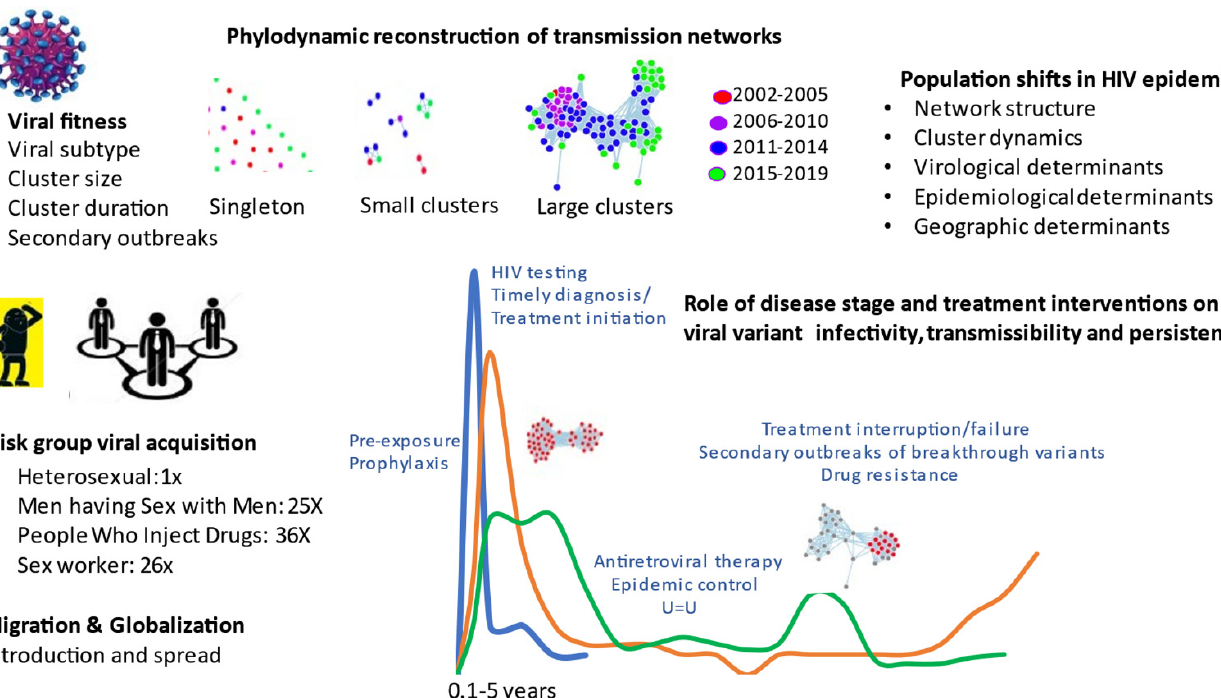
Figure 1. Phylogenetics inferences in HIV transmission towards epidemic control.